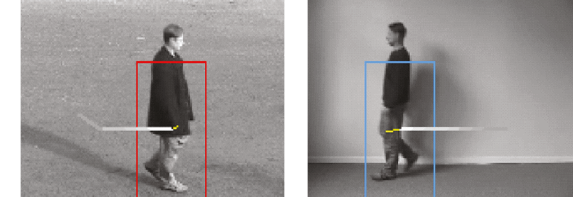
Figure 21: Tracking samples of baseline method using KTH